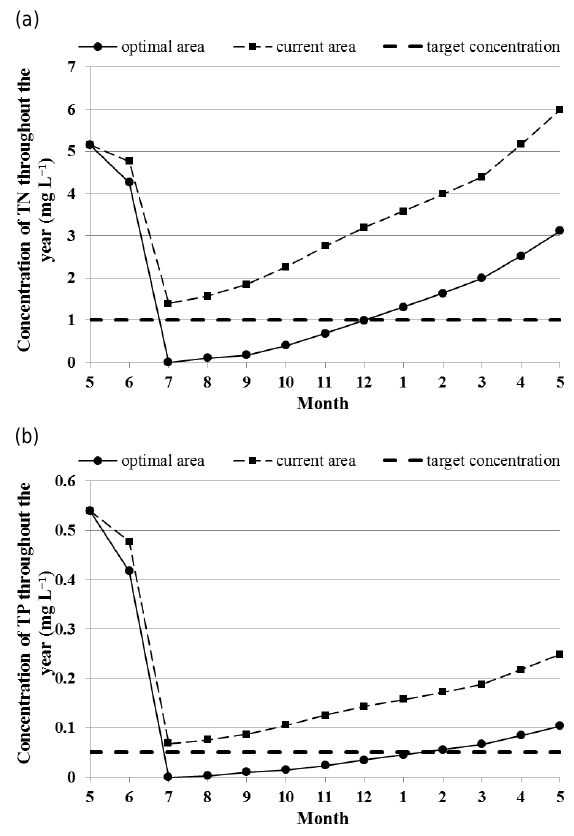
Figure 1. Lake water quality throughout the year under the optimal Fig 1. Lake water quality throughout the year under the optimal and current reed areas 4 and current reed